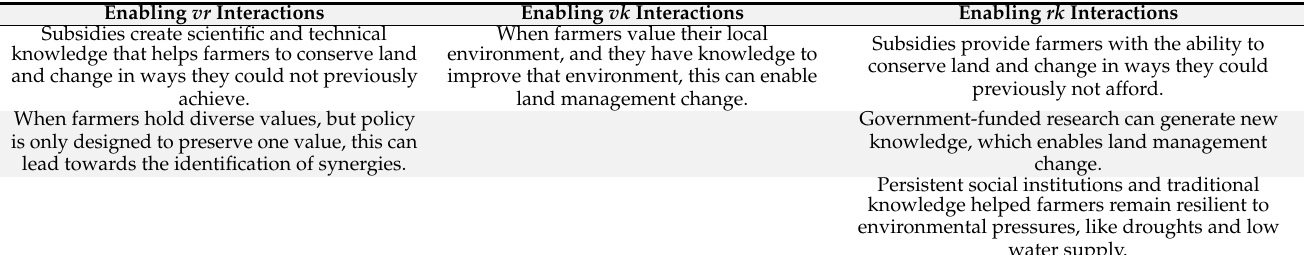
Table 5. The values–rules, values–knowledge, and rules–knowledge interactions that enabled land management change as an adaptation response.